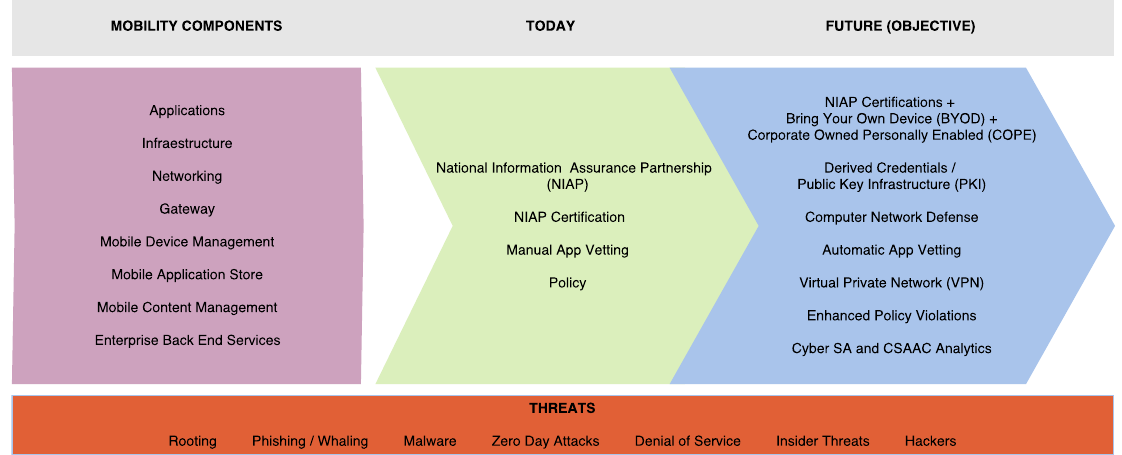
Figure 9. Mobility components and their